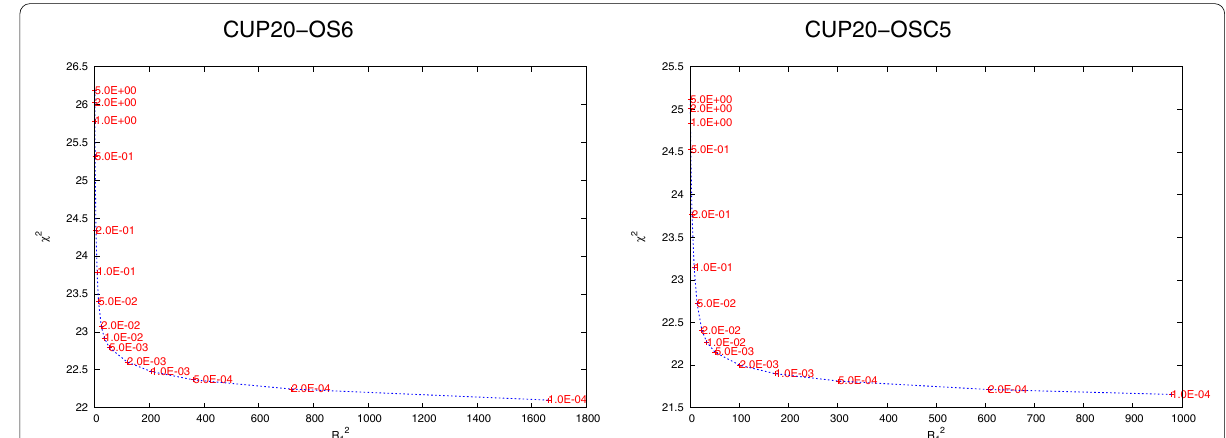
Fig. 3 Trade-off plots between data misfit and regularization (the L-curves) for CUP20-OS6 (left) and CUP20-OCS5 (right) inversions, respectively. The red numbers denote the respective values of the regularization parameter (cid:31)